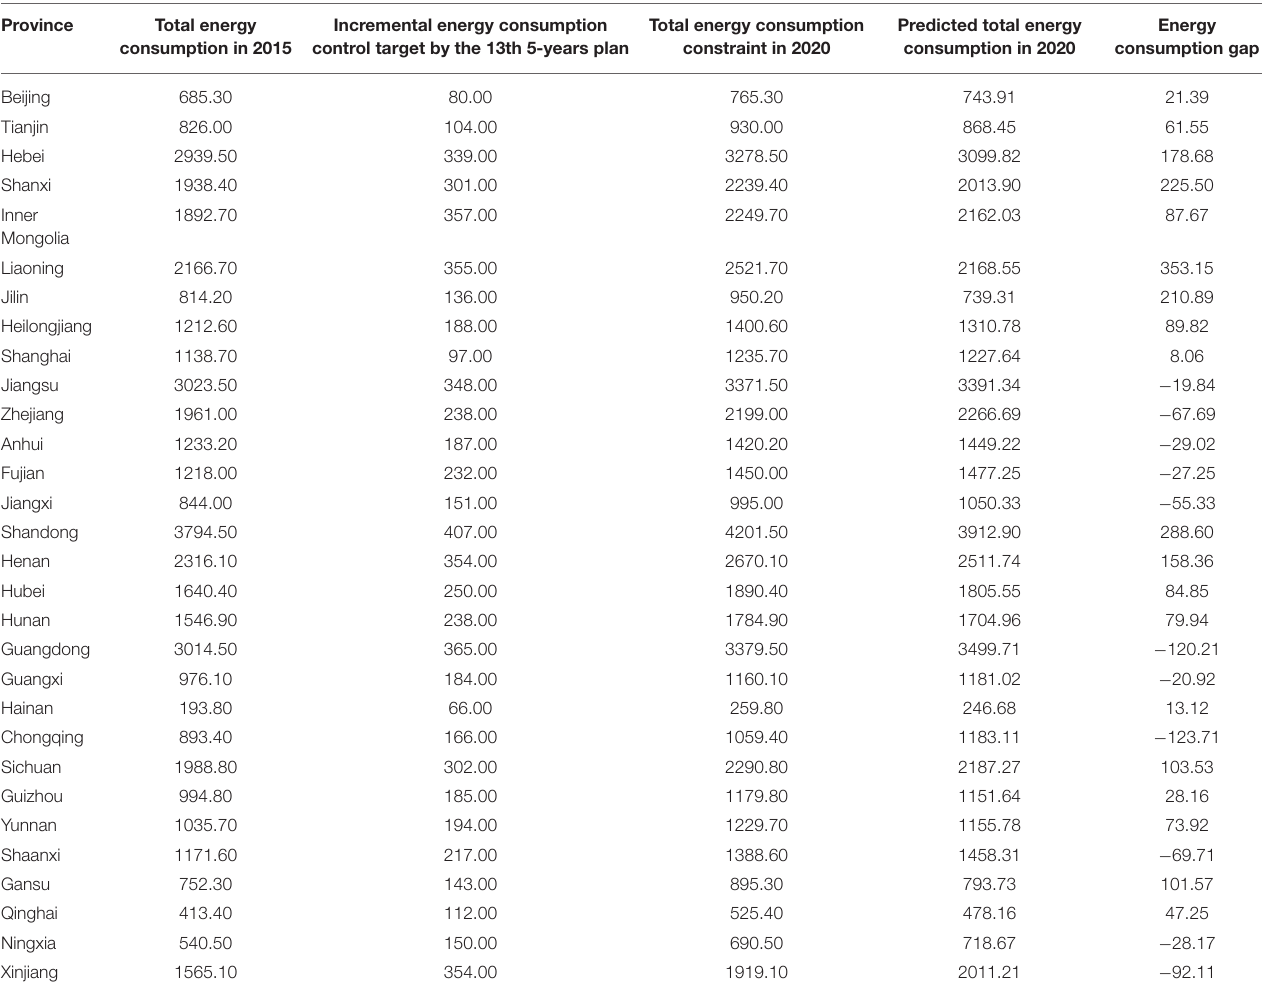
TABLE 3 | Each province’s energy consumption constraints and energy consumption gap (Mtce).